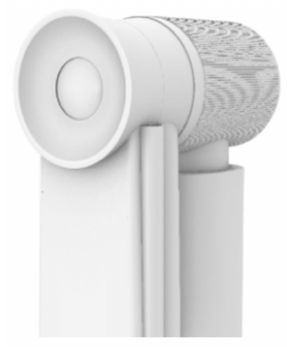
Figure 21. Telescopic main rod.